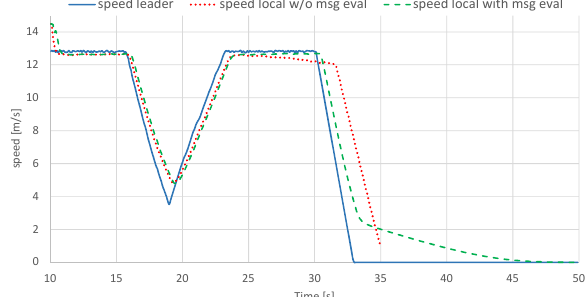
Figure 6: Speed of the leading vehicle and CACC controlled local vehicle